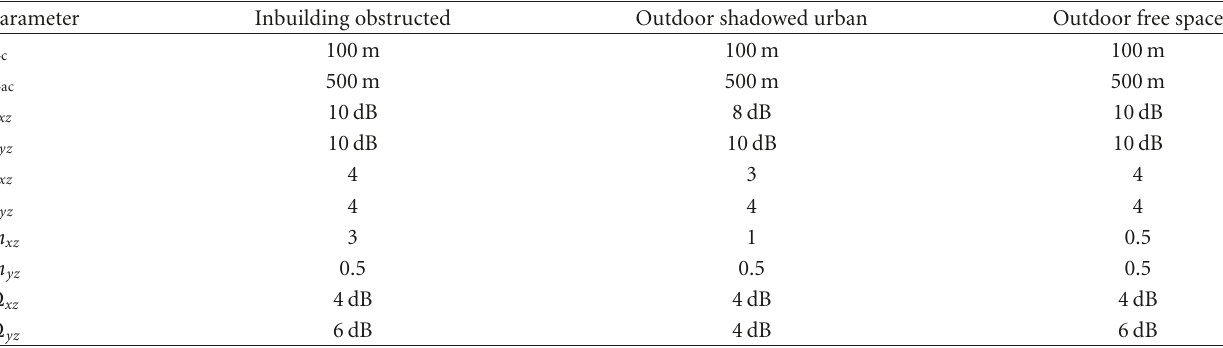
Table 3: System parameters for Figure